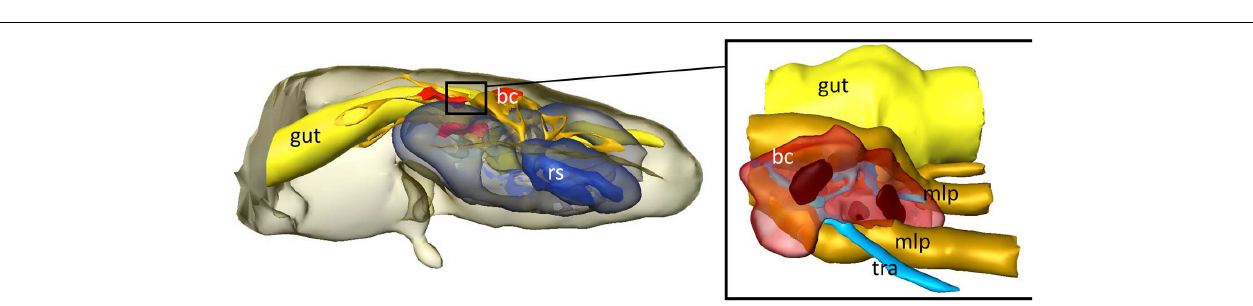
FIGURE 3 | Fluorescence in situ hybridization of ‘ Candidatus Dasytiphilus stammeri’ in the bacteriomes of a female Dasytes plumbeus. (a) Cross-section through the entire abdomen of D. plumbeus , and (b,c) close-ups of bacteriocytes. Symbionts were specifically stained with Dasy_Ent-Cy5 (green), while the general eubacterial probe EUB388-Cy3 (red) and DAPI (blue) were used for counterstaining. Abbreviations: bc, bacteriocytes; ov, ovaries.